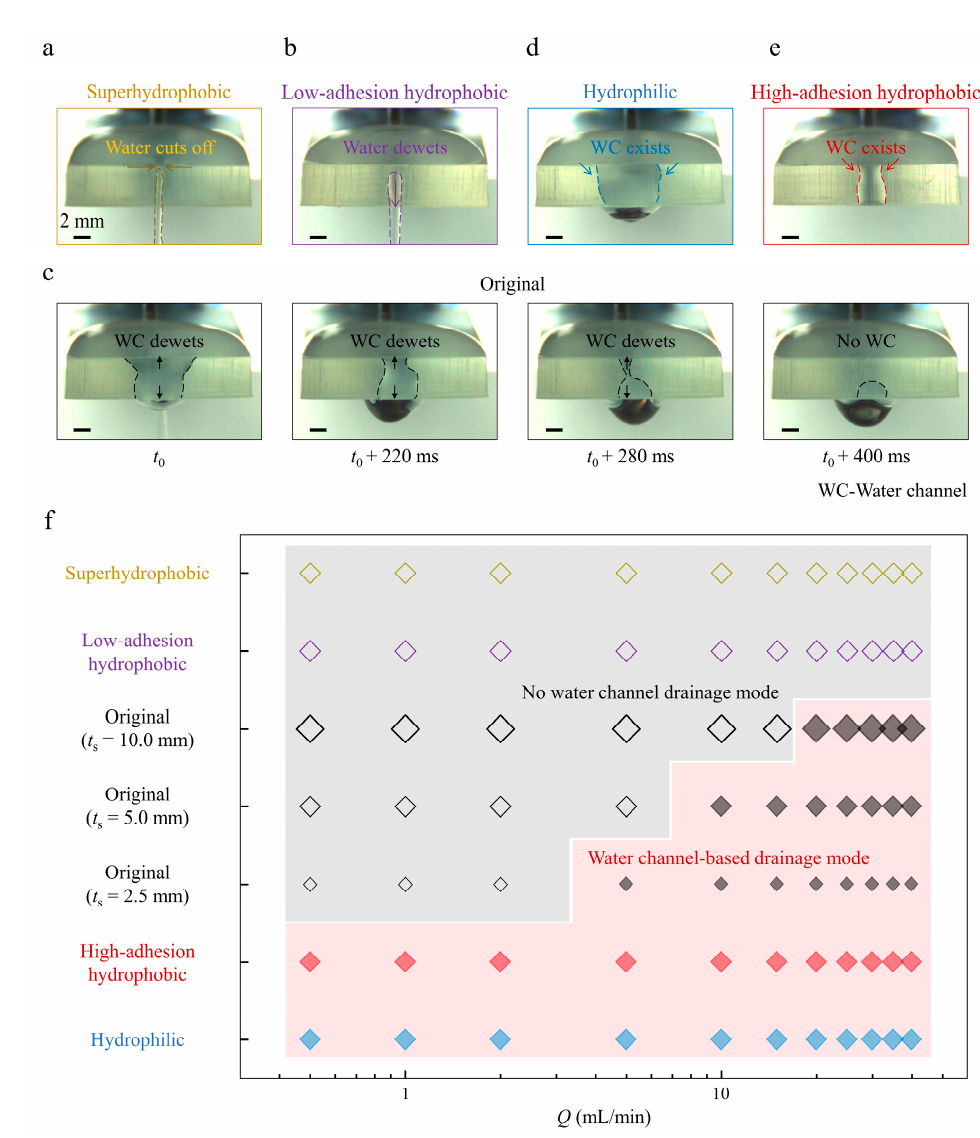
samples; Figure S2: Adhesion forces of margin surfaces with different wettability modifications; Figure S3: Selected drainage snapshots for samples of margins with different wettability